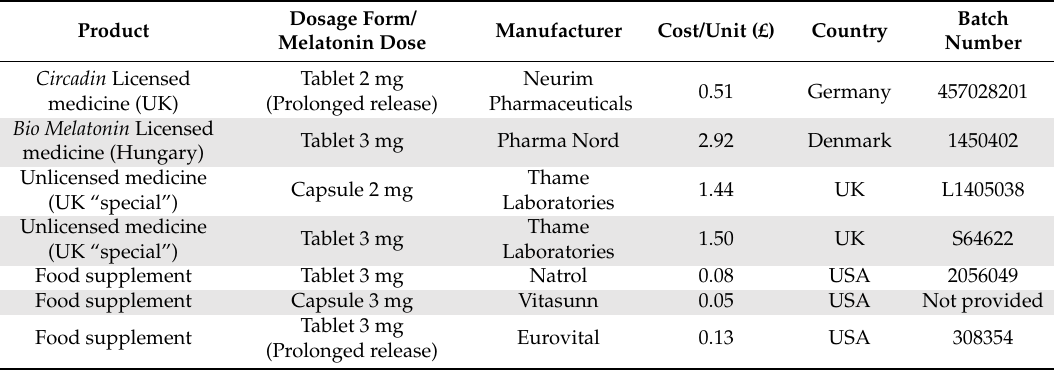
Table 1. Solid oral dosage forms containing melatonin used in the